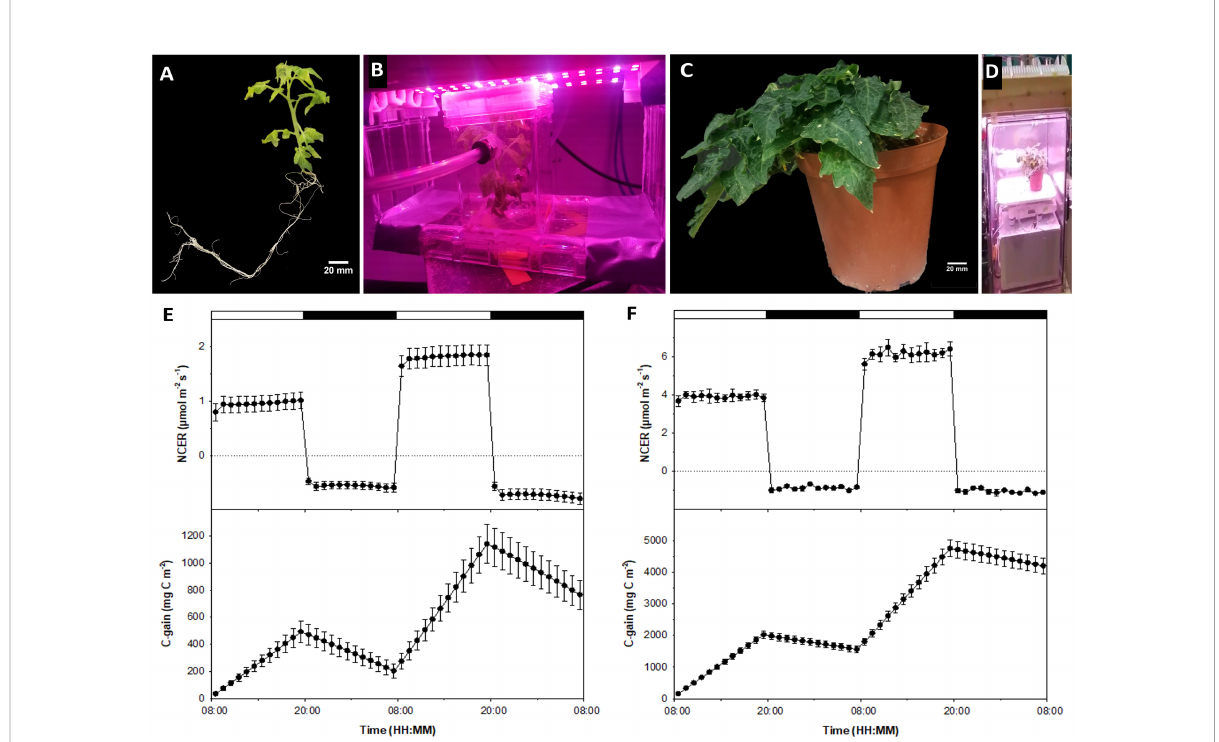
FIGURE 1 Comparing tissue culture and conventional whole-plant systems. Shown are (A) tissue culture MicroTom grown from seed; (B) in vitro MicroTom connected to the non-invasive tissue culture gas exchange system using the methods presented by Pepe et al. (2022) and Leonardos and Grodzinski (2014); (C) 8-week old MicroTom grown with potting soil in growth cabinets; (D) potted MicroTom in whole-plant gas- exchange system (see Leonardos and Grodzinski, 2016) equipped with white-red LED fi xtures (Lighting Science Group Company, RI, USA); (E) tissue culture NCER and carbon gain; and (F) cabinet grown plant NCER and carbon gain. Error bars represent means and standard errors of four